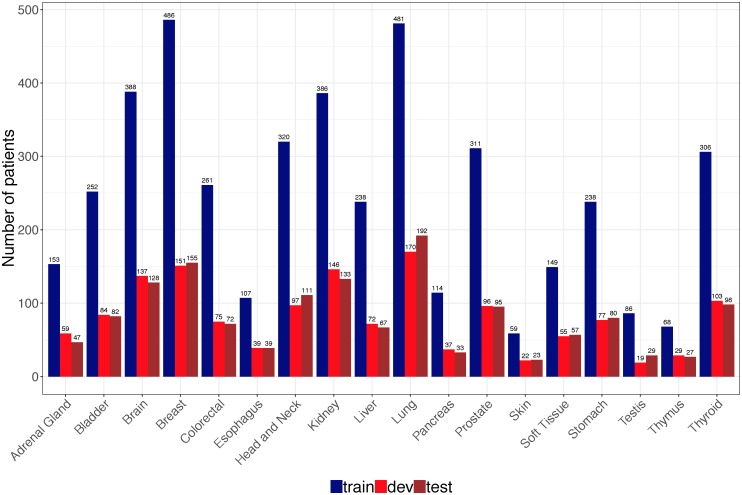
Distribution of cancer samples in TCGA by tissue of origin.A total of 7339 patients were randomly and stratified split into train, dev and test sets according to 60:20:20.